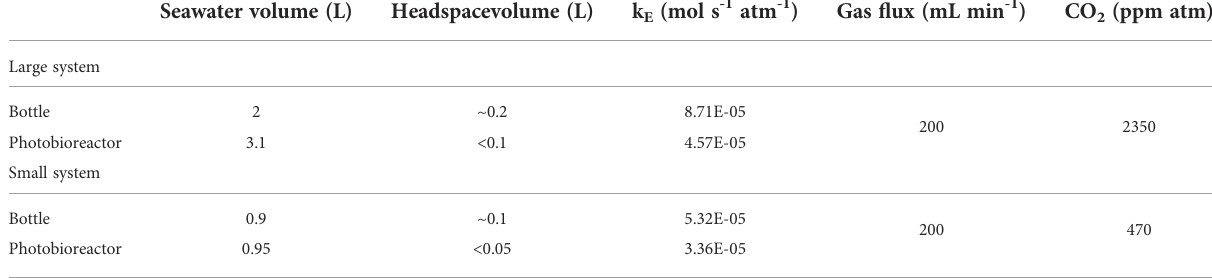
TABLE 1 Parameters for photobioreactor systems.